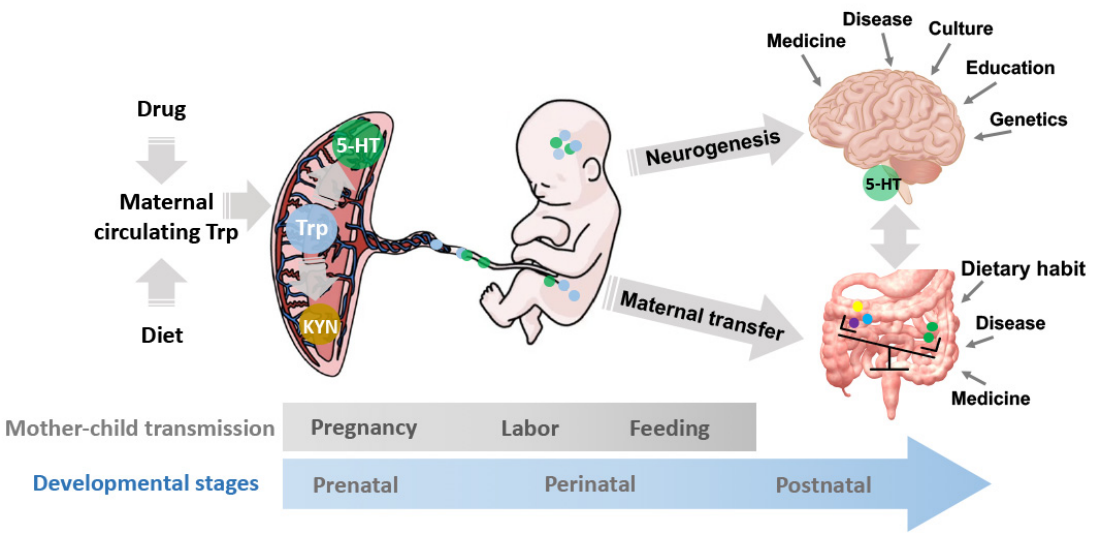
Figure 1. The mechanisms underlying the gestational Trp fluctuation on prenatal, perinatal, and postnatal development. The maternal circuiting Trp is affected by multiple factors, such as drug administrations and diets. The placental Trp can be synthesized to 5-HT, degraded to KYN, or transferred to the embryo. The fetus is exposed to the Trp and its metabolite, 5-HT, and KYN, which regulates the neurogenesis and neuroendocrine development as well as the gut microbiota composition and diversity in the progeny. The mother-child microbe transmissions during the 40-week pregnancy, labor, and feeding constitute the initial microbiota community in the progeny and con- sequentially, regulate decision making and behavioral exhibition via the MGB axis. The develop- ment and activity of the MGB axis are regulated by the maternal-fetal transfers of nutrients and microbes together with multiple environmental factors, including the disease and medicinal history, culture, eating habits, education, etc. 5-HT: serotonin; KYN: kynurenine; MGB axis: microbiota-gut- brain axis; Trp: tryptophan. 3. Maternal Trp Fluctuation Alters Neuroendocrine and Gut Microbiome in Offspring To propose the perspective of gestational Trp fluctuation affecting psychosocial de- velopment in offspring, the existing evidence has been reviewed and presented in Table 1. Maternal Trp fluctuation by the Trp-enriched or -depleted diet during pregnancy alters the fetal neuroendocrine and microbiome, which may reprogram the development of the hypothalamic-pituitary-adrenal (HPA) and hypothalamic-pituitary-gonadal (HPG) axes and mediate the activity of the microbiota-gut-brain (MGB) axis in offspring, conse- quently reprograming the psychosocial development. Table 1. Non-comprehensive review of the effects of maternal Trp administration on the physiolog- ical and behavioral exhibitions in offspring. Species